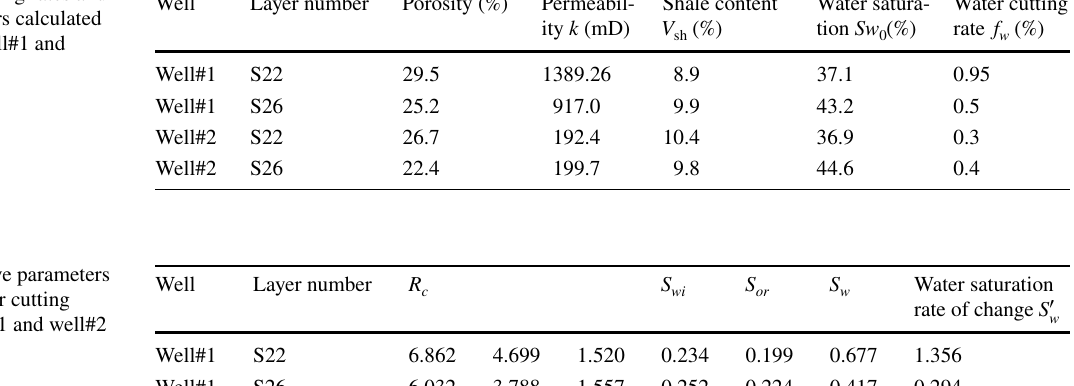
reservoir parameters calculated by logs of infill well#1 and well#2